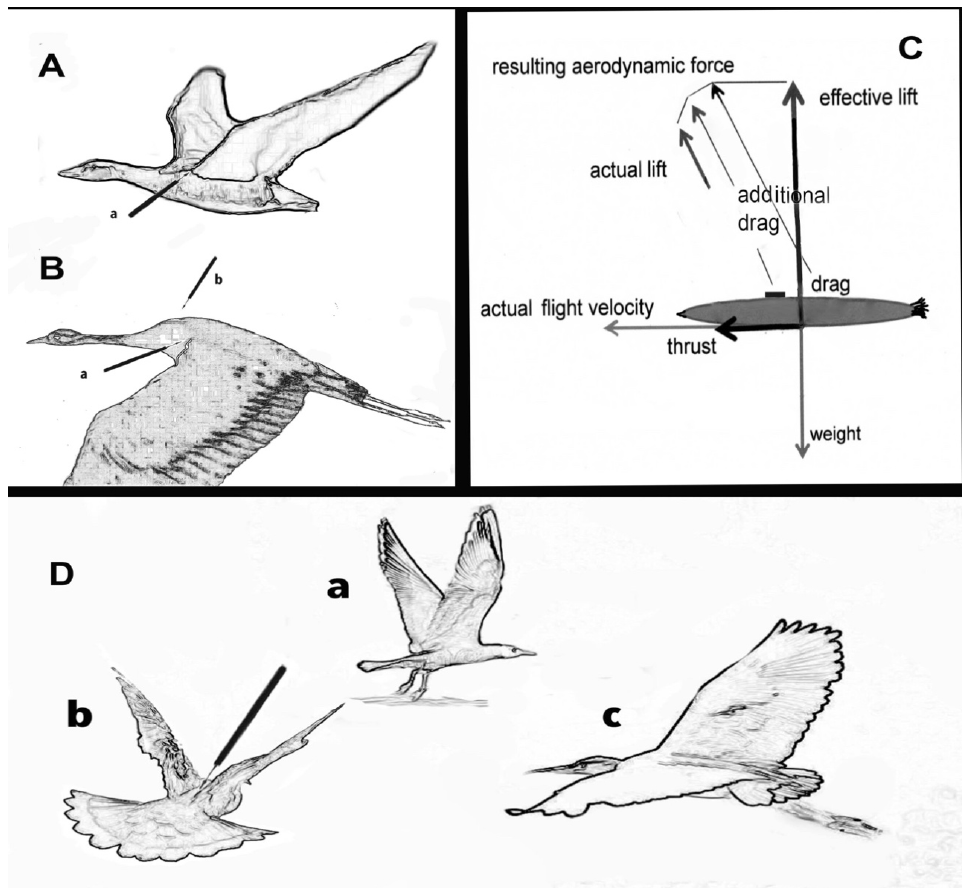
Figure 4. Flight positions. ( A ) Upward movement a: arrow points to pressure point of harness cutting into edge of wing. ( B ) Smooth downward movement b: where device would be attached. ( C ) Diagrammatic presentation of the body of a bird (excl. wings): the process of lift and thrust and the aerodynamic forces that determine actual lift and velocity, showing how the device (black box, dorsal position) creates extra drag. ( D ) ( a – c ) showing different flight positions; in ( b ) arrow indicates how the device interferes with the upward swing; in some species it can even prevent the full upward movement of the wings and thus make the lift more difficult; in ( c ) there would be least wing contact with a back-fitted device but maximum drag.